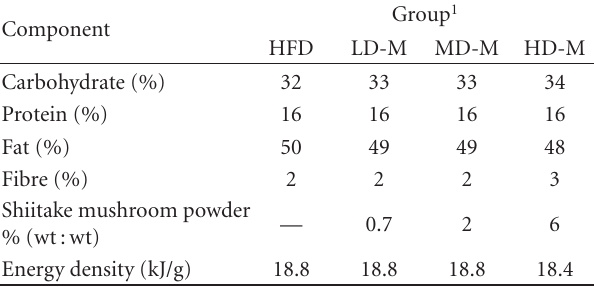
Table 1: Composition of experimental